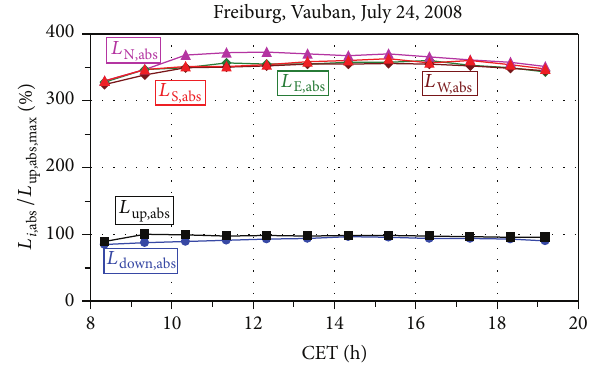
Figure 20: 1h mean values of differences Δ of air temperature Figure 19: 1h mean values of the long-wave radiant flux densities 𝑇 𝑇 , and physiologically equivalent 𝑎 , mean radiant temperature 𝑖 = down, up, E, S, W, and N) from the three-dimensional 𝐿 mrt 𝑖, abs ( temperature PET between a shaded (by tree canopies) and sunny environment absorbed by the human-biometeorological reference SSW-facing sidewalk of a WNW-ESE street canyon, “Vauban” ( 𝐿 = 28W/m 2 ), person, related to the 1h peak value of 𝐿 up , abs up , abs , max quarter in Freiburg during typical Central European summer day. SSW-facing sidewalk (shaded by tree canopies) of a WNW-ESE street canyon, “Vauban” quarter in Freiburg during typical Central European summer day. , and PET by two Table 3: Maximal relative reduction Δ of 𝑇 𝑎 , 𝑇 mrt , and PET shading methods related to the mean values of 𝑇 𝑎 , 𝑇 mrt over 12–15 CET, based on results of both human-biometeorological measuring campaigns in Freiburg during typical Central